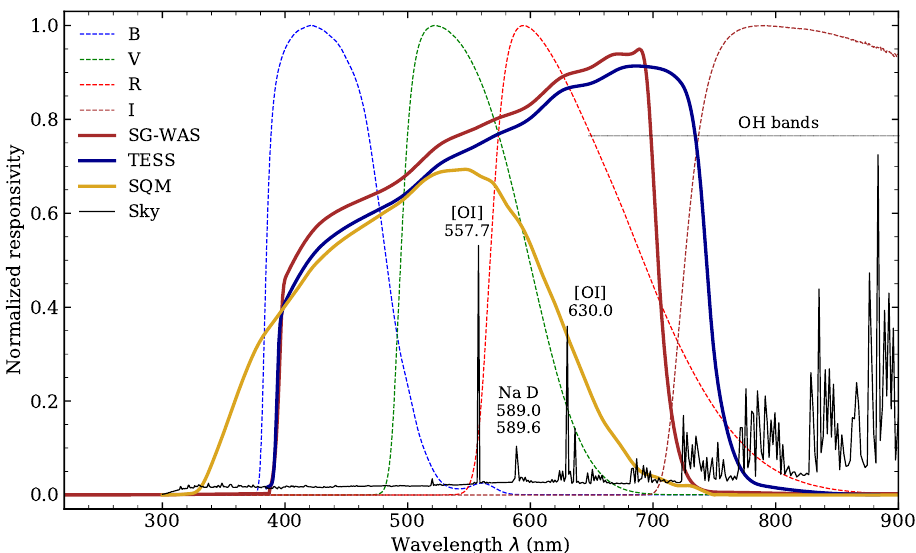
Figure 5. Spectral response curve of the SG-WAS. The sensitivity of the TSL237 sensor is limited to the visible range by a dichroic filter, and the window has been removed to improve the transmittance of the optical system. The transmittance of the TESS-W and SQM-L photometers and Johnson– Cousins [25] BVRI filters has been included as a reference, as well as the night sky spectrum obtained using the SkyCalc tool [26], where the brightest airglow lines are labeled. Adapted with permission from [10] ©AAS